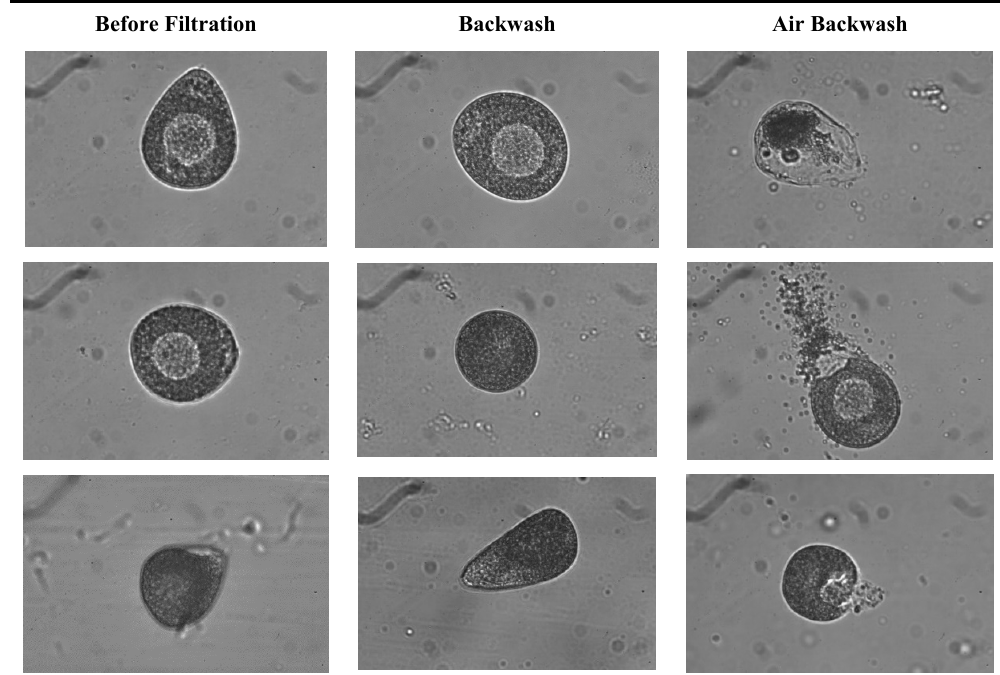
Figure 9. Pictures of oocytes before filtration and in backwash water.